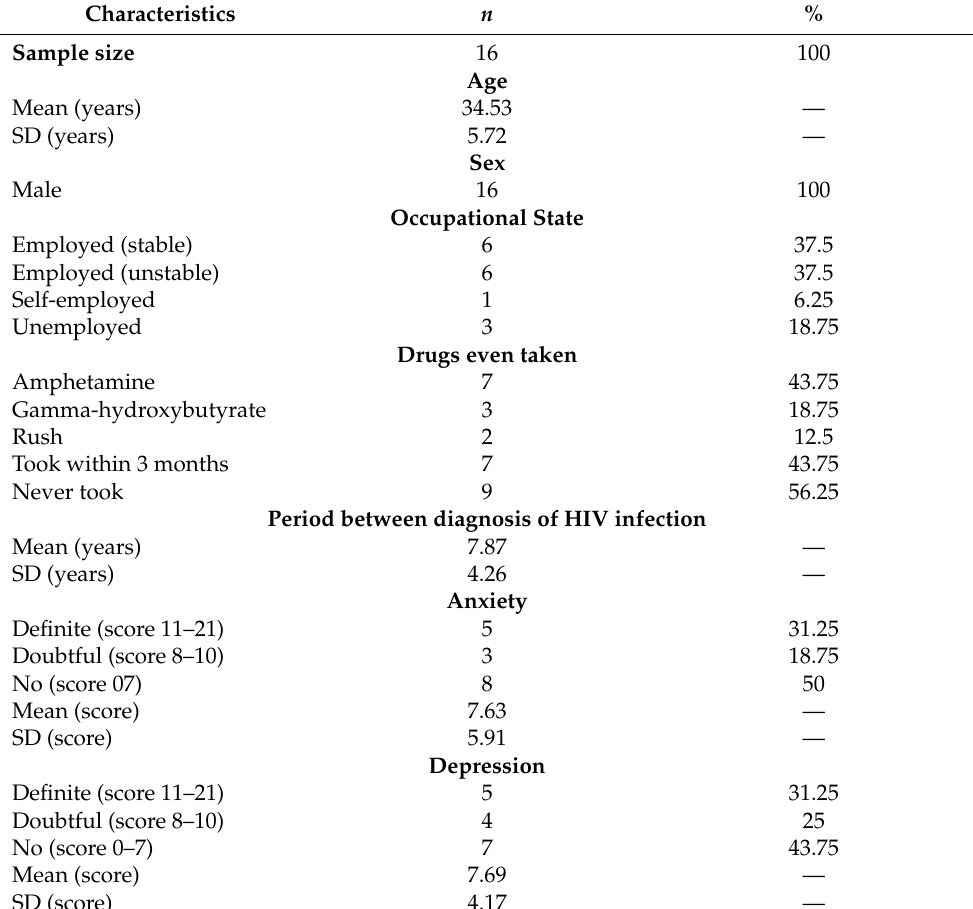
Table 1. Demographic data of the 16